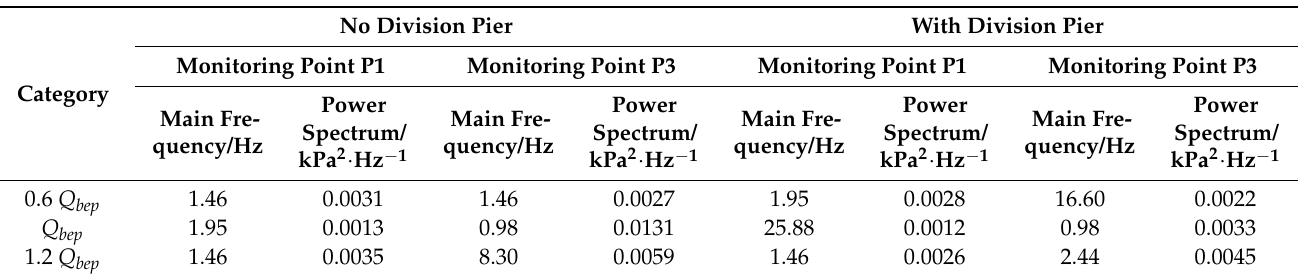
Table 3. Power spectrum of each monitoring point after reconstruction of the signal of sub-band 0~31.25 Hz under each working